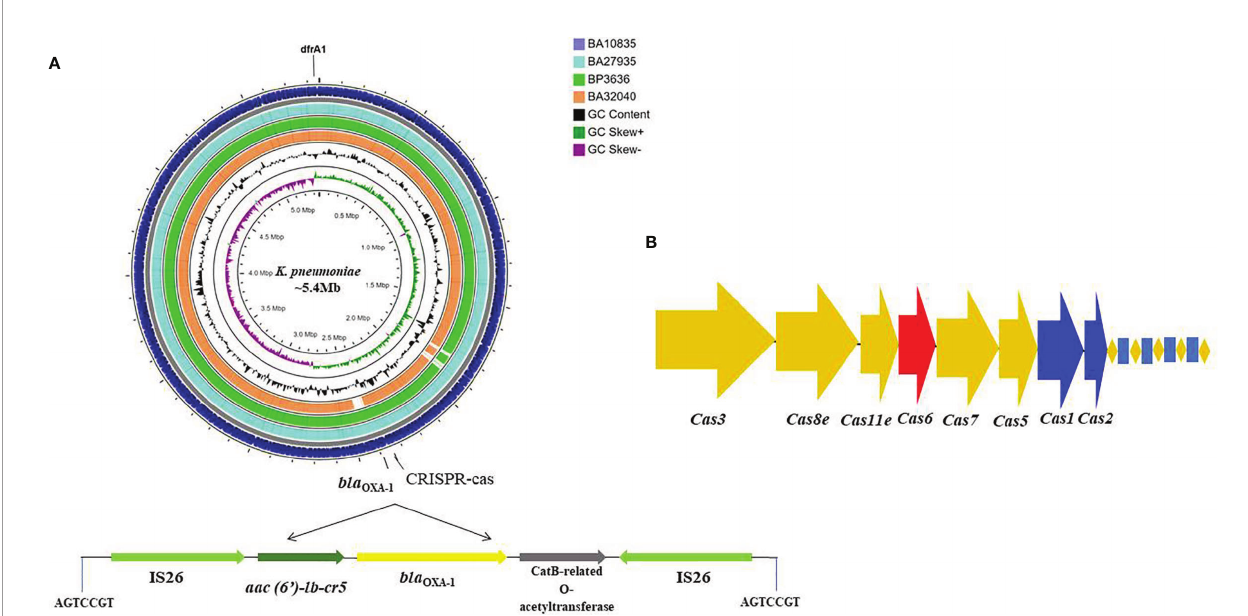
FIGURE 1 | Circular genome map of four MDR hypervirulent K. pneumoniae ST2096 chromosomes. (A) Circles from the outside to the inside show the CDS region of BA10835 (blue), BA27935 (cyan), BP3636 (green), BA32040 (yellow), GC skew (dark green and purple), and GC content (black). Linear view of the IS 26 mediated trans locatable units carrying aac(6 ′ )-Ib-cr ( fl uoroquinolones and aminoglycosides), bla OXA – 1 (ampicillin), and catB3 (chloramphenicol) inserted to the chromosome. A repeat region of 7 bases read as AGTCCGT was present on either ends where the insertion was observed. Map generated using CGView server (Grant and Stothard, 2008). (B) Type I-E CRISPR-Cas system identi fi ed in the chromosomes with repeat region of 28